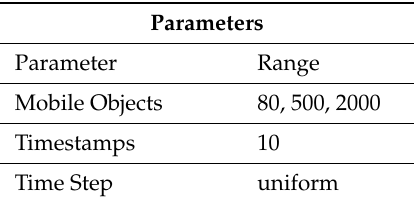
Table 6. Simulation